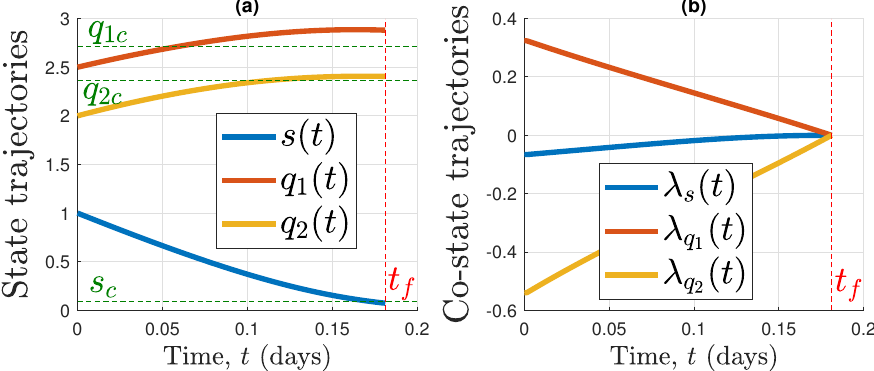
= 0.3) is of bang(0)-singular type. = 1.9, x 0 i i